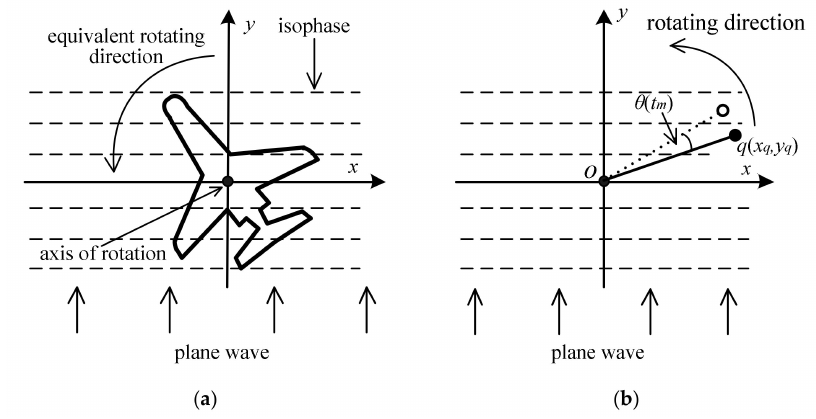
Figure 1. Rotating platform imaging model of targets. ( a ) The geometry of an airplane in ISAR imaging, ( b ) the rotated angle of the